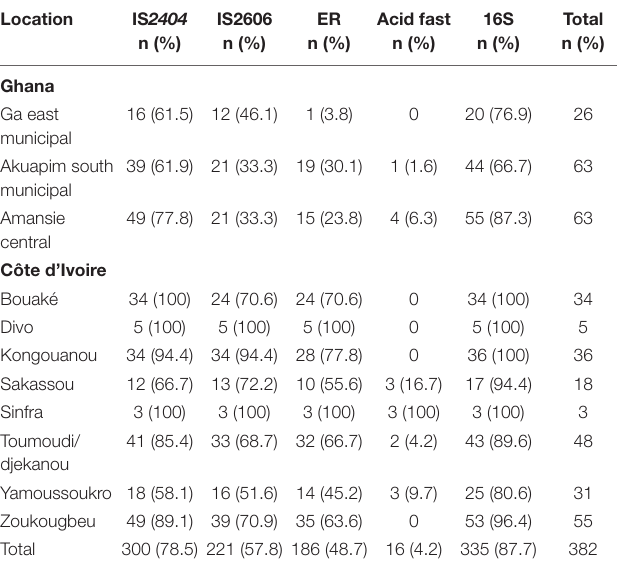
TABLE 2A | Proportions of confirmed BU cases using different BU confirmatory tool.